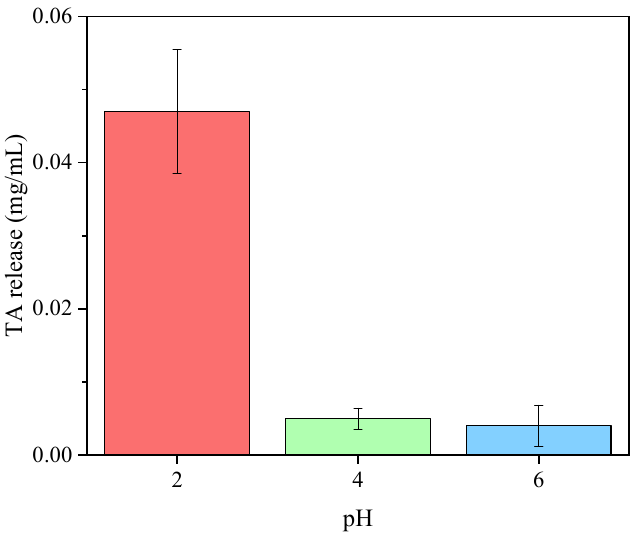
Figure 6. Folin–Ciocalteu determination of TA in the CuSO 4 solutions after 24 h of adsorption treatment by CHg-TA.